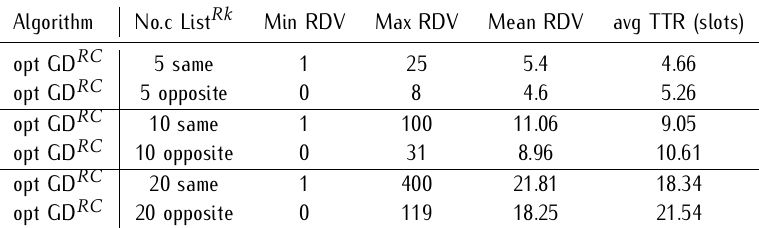
Table 5. Slot synchronized CRs: Minimum (Min), Maximum (Max) and average (Mean) number of potential RDVs per cycle and average TTR (slots) for the opt gQS scheme; No.c stands for Number of channels; List Rk is the channel ranking lists Algorithm